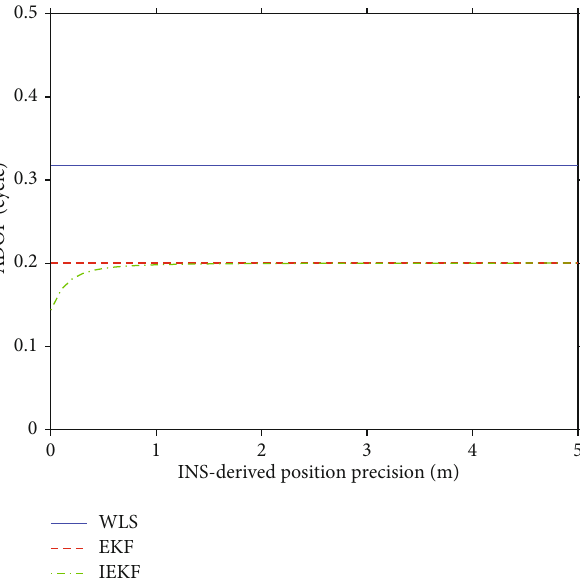
Figure 8: The ADOP values with INS-derived position precision (Data 1).